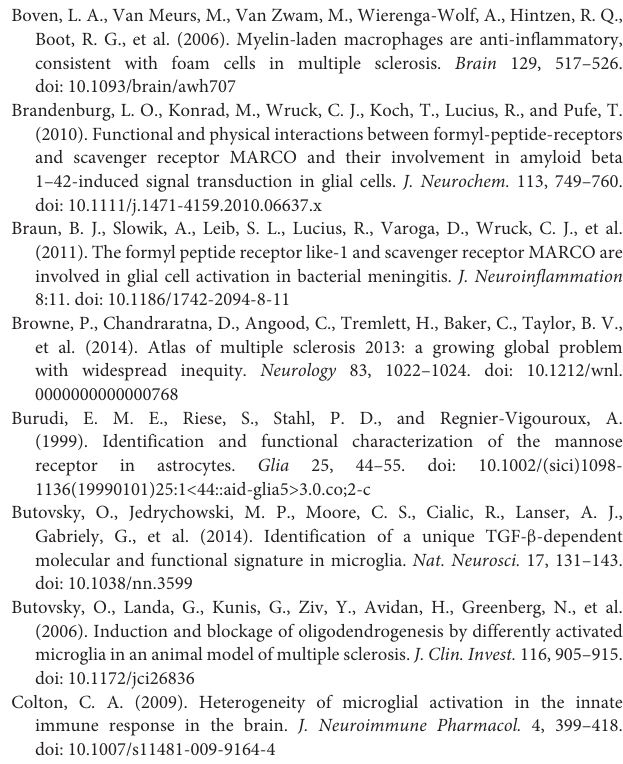
FIGURE S1 | Weight changes during the experiment. Percentage weight changes between the first and the last 2 days of the experiment in (A) young and (B) middle-aged mice. In both age groups, no significant differences were observed in relative weight changes in comparison to the respective controls. Values are shown as means + SD ( n = 6 per group). Statistical significance was evaluated using a one-way ANOVA and a Tukey’s post hoc test (A) and a Kruskal-Wallis one-way analysis followed by a Dunn’s multiple comparisons test (B)